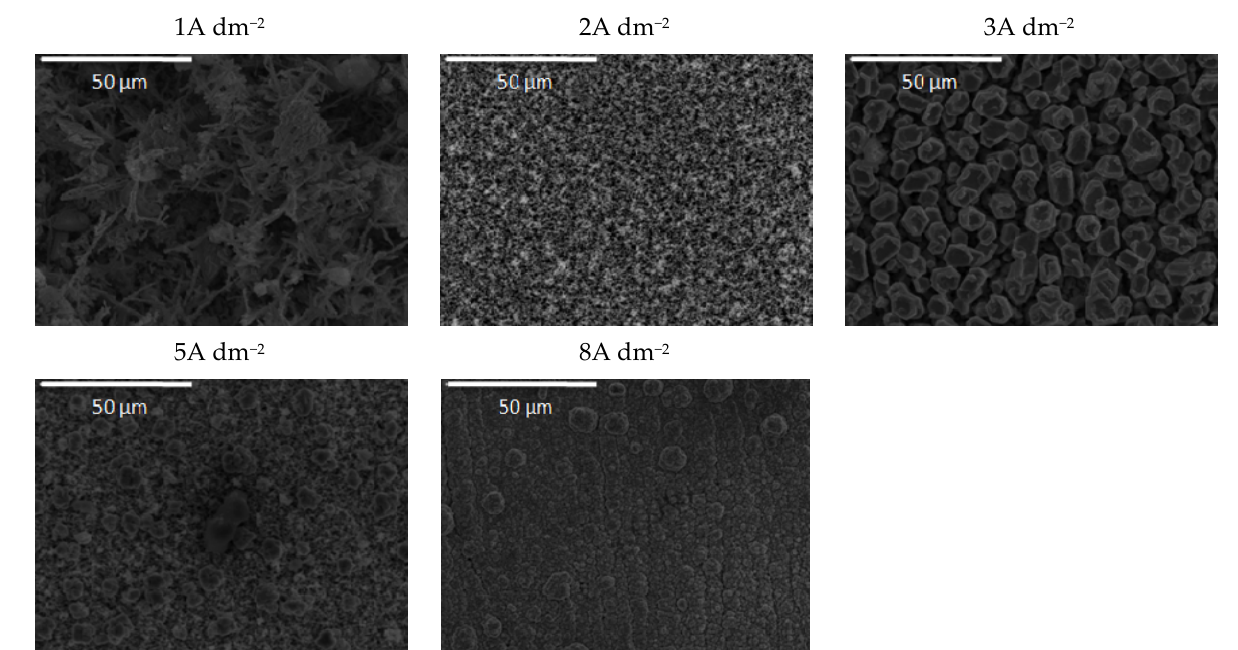
Figure 10. Morphology of the Zn-Co-CeO 2 composite coatings ultrasounddeposited at different current densities from the plating solution with 0.2 wt.% ceria powder.